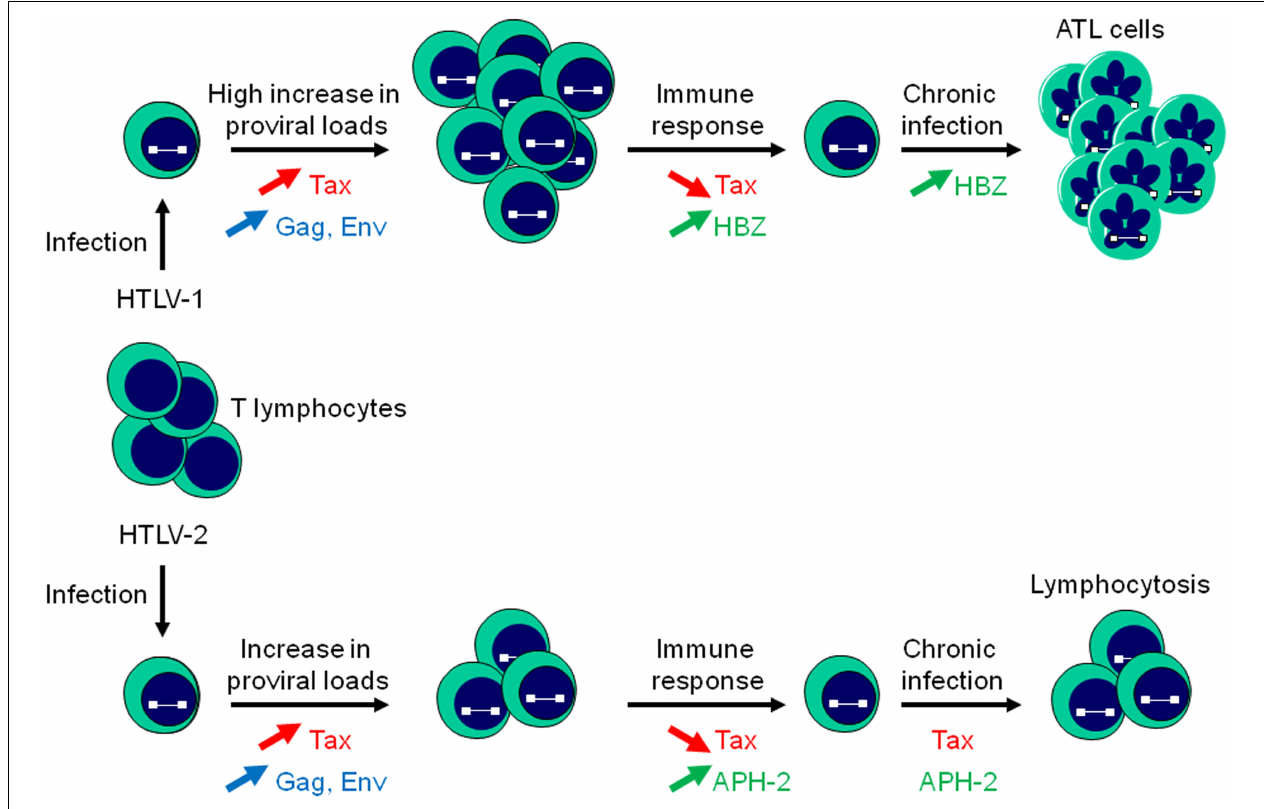
promote the establishment of a chronic infection by inhibitingTax-dependent viral transcription, stimulating its own expression, and inducingT cell proliferation. APH-2 also down-regulatesTax-dependent HTLV-2 transcription but is unable to induce cell proliferation. A low expression ofTax induced by APH-2 through its capacity to positively modulate c-Jun activation could be responsible for HTLV-2-stimulated